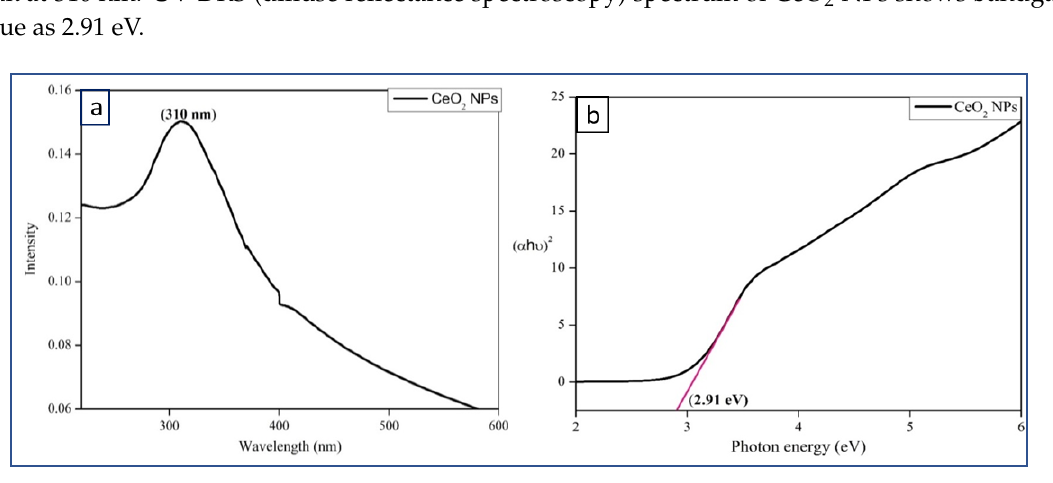
Figure 2. (a) UV-Visible spectrum of CeO 2 NPs, (b) UV-DRS spectrum of CeO 2